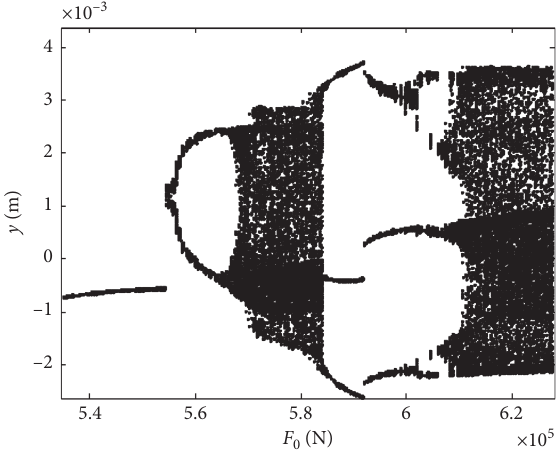
Figure 10: Bifurcation diagram of the vertical vibration under varying external excitation